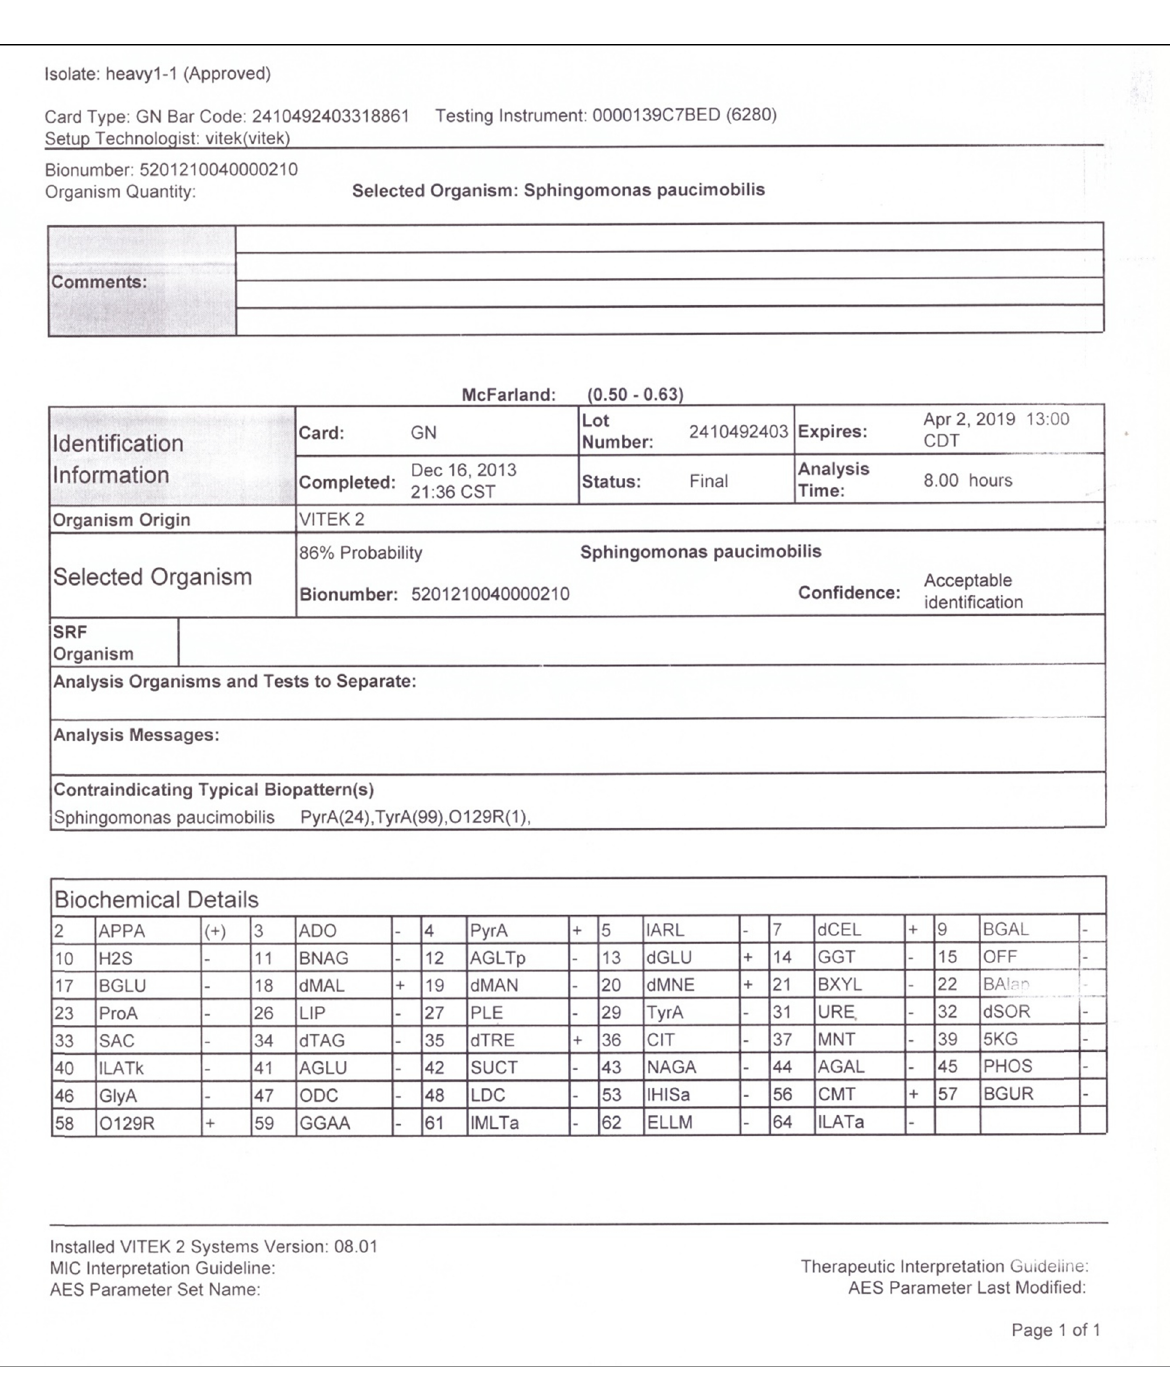
Impact of green AgNPs synthesized by red alga on chicks ’ performance 